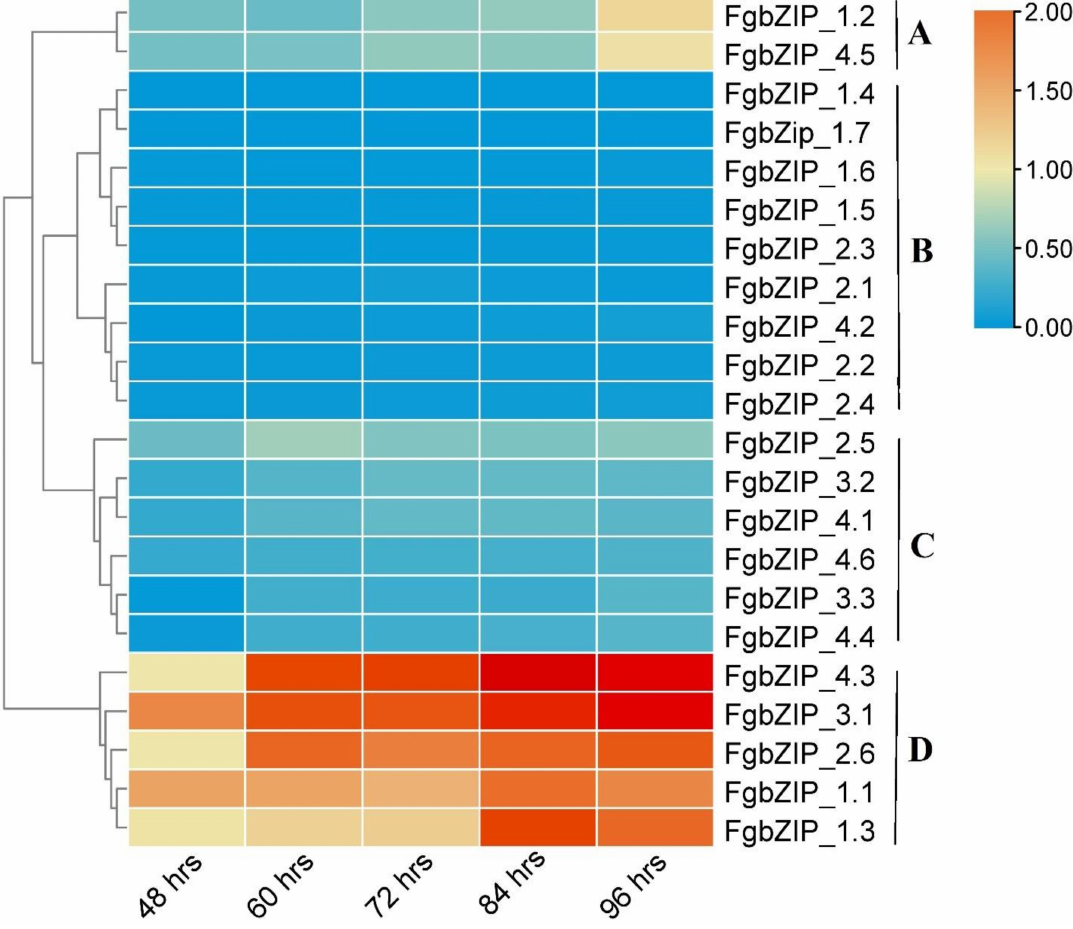
Figure 7. Relative expression pattern of FgbZIP genes under different stages of development. Relative expression values of RT-qPCR results were transformed by log2. Light and dark colored boxes reveal lower and higher expression levels, respectively according to the scale. The alphabets A–D on the right depicts grouping based on the expression of